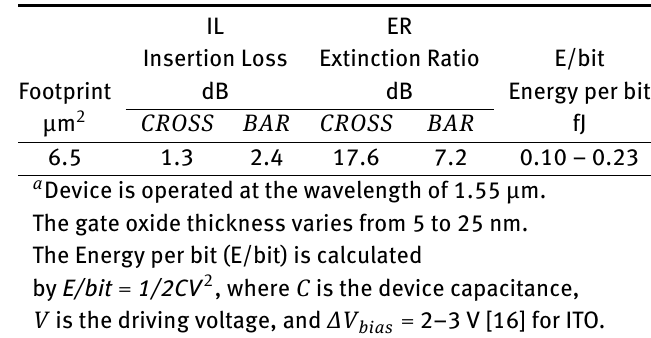
Table 1: Quantitative performance estimates a for the compact plasmonic EO